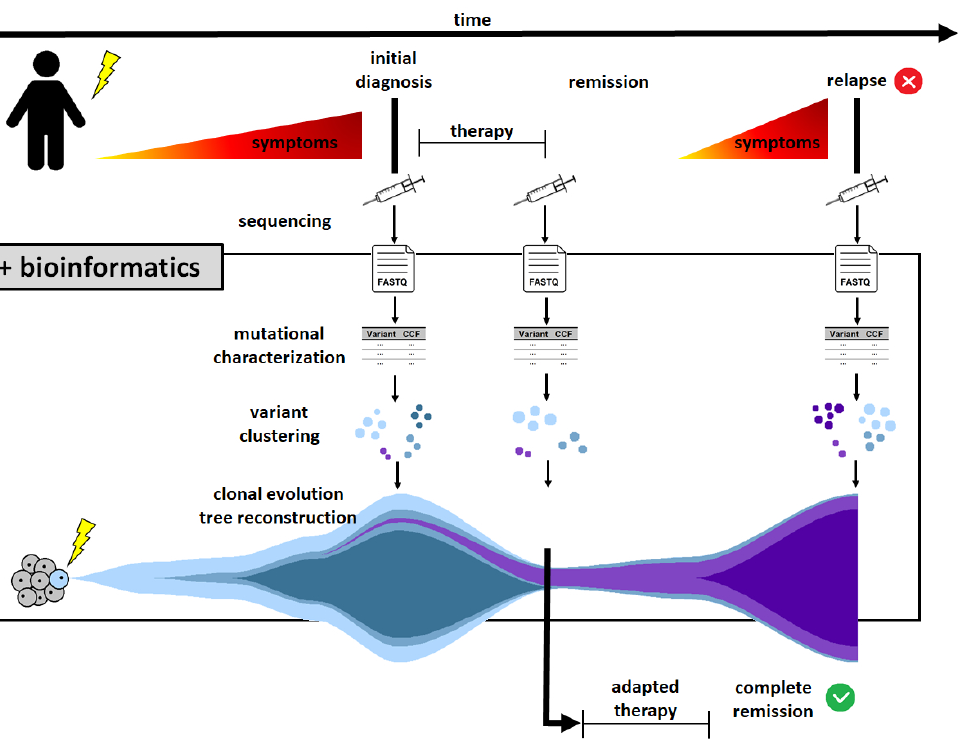
Figure 1. The role of bioinformatics in precision oncology. When performing sequencing experiments in the course of disease, bioinformatics analyses allow for performing mutational characterization of a tumor. Subsequently, data can be used to reconstruct clonal evolution, including variant clustering and clonal evolution tree reconstruction. Thereby, aggressive subclones (purple), which are resistant to therapy and may lead to relapse, can be identified early and therapy adapted